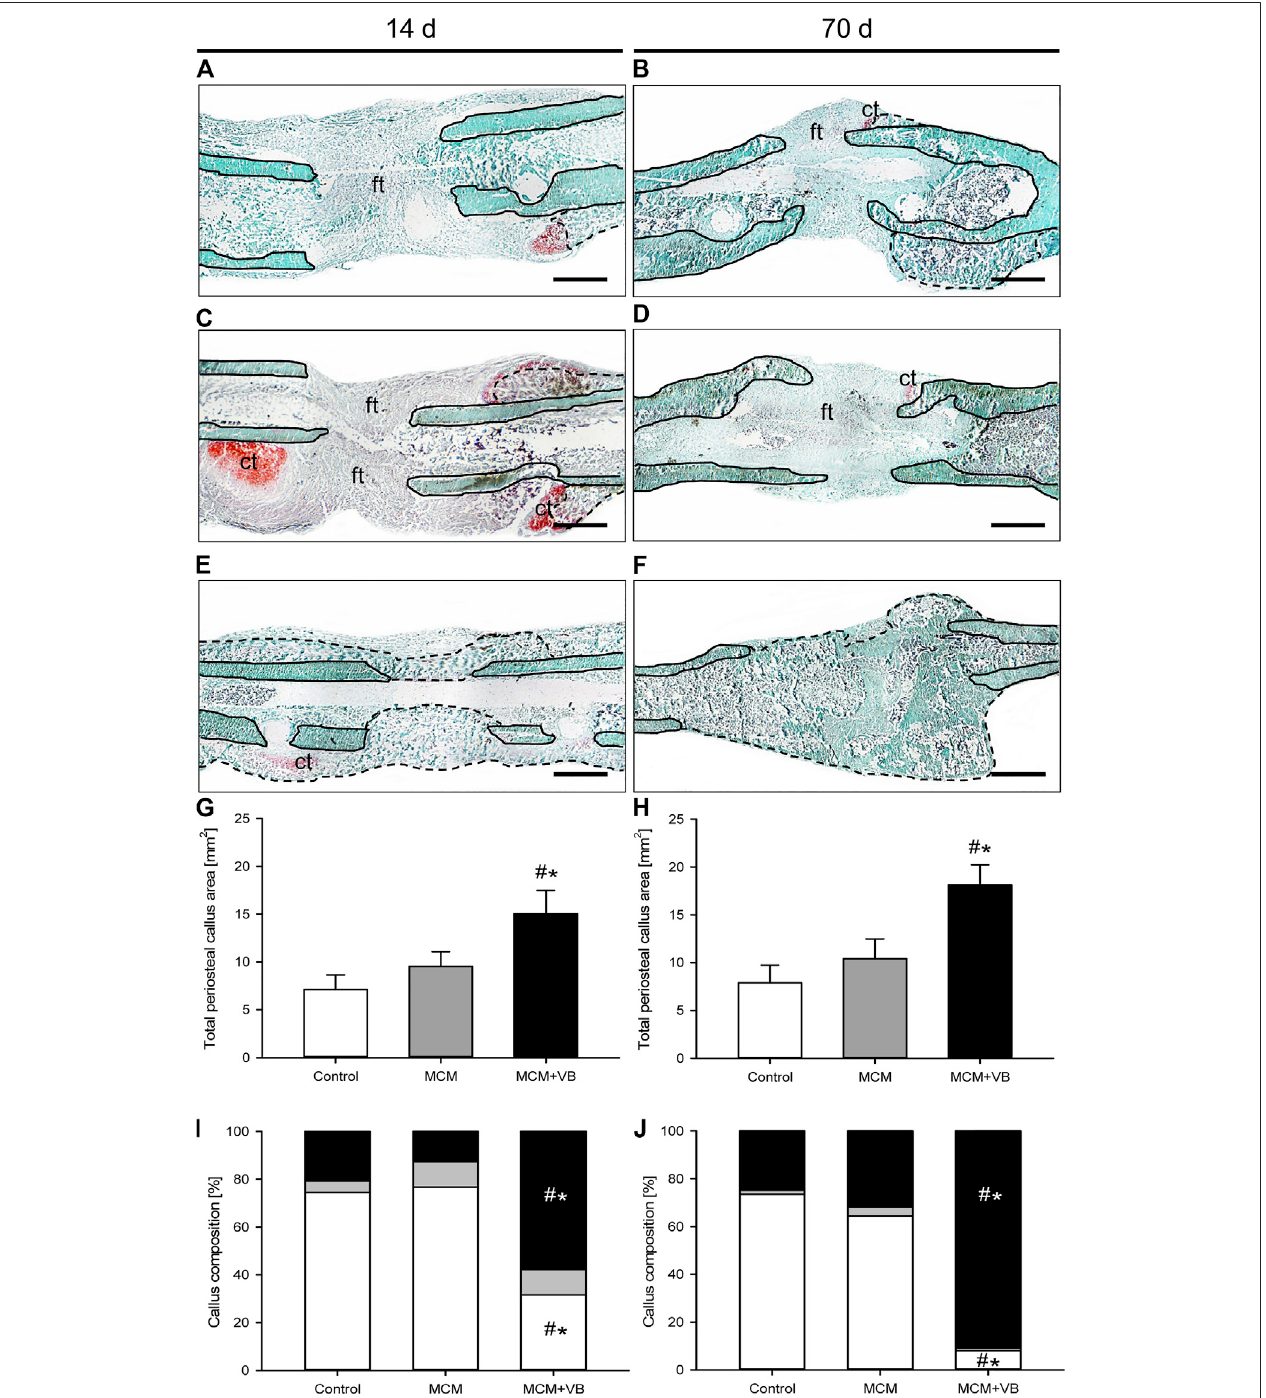
FIGURE 5 | Histomorphometric analysis of mouse femurs. A-F: Representative histological images of Safranin-O-stained femurs at 14 days (A, C, E) and 70 days (B, D, F) after osteotomy of control (A, B) , MCM (C, D) and MCM + VB (E, F) animals. Fibrous tissue (ft), cartilage tissue (ct), native bone (borders marked by solid line), and regenerated bone (borders marked by dashed line) are indicated. Scale bars: 500 µm. G, H : Total periosteal callus area of control (n (cid:1) 8), MCM (n (cid:1) 8) and MCM + VB (n (cid:1) 8) femurs at 14 days (G) and 70 days (H) after osteotomy. I, J : Callus composition including fi brous tissue (white), cartilaginous tissue (gray) and osseous tissue (black) of control (n (cid:1) 8), MCM (n (cid:1) 8) and MCM + VB (n (cid:1) 8) femurs at 14 days (I) and 70 days (J) after osteotomy. Mean ± SEM; # p < 0.05 vs control; * p < 0.05 vs MCM.